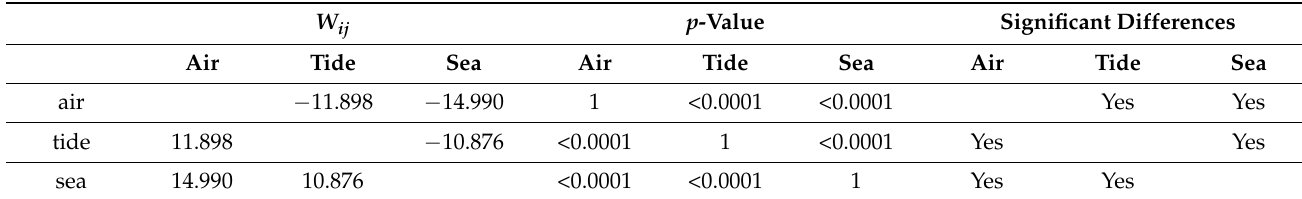
Table 16. Two-tailed Steel-Dwass-Critchlow-Fligner test details for the NiTi-2 alloy. W ij p -Value Significant Differences Air